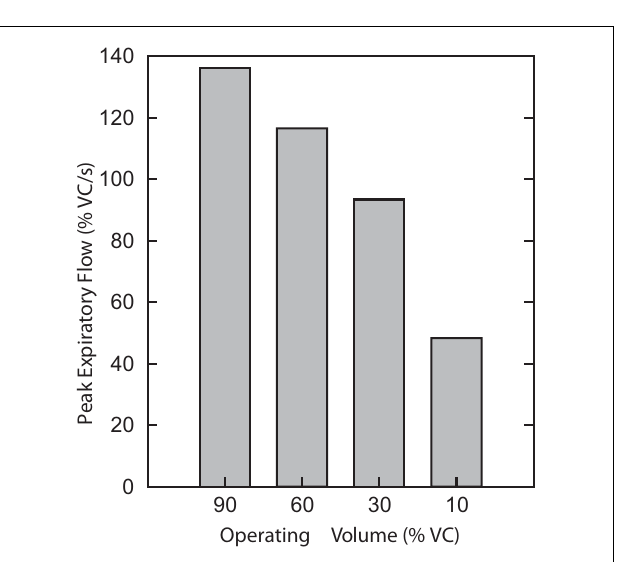
FIGURE 7 | Peak expiratory flow in four coughs simulated with the isolated biomechanical model at different operating volumes but equal peak abdominal pressure of 26.5cmH 2 O. There are no error bars because these are runs of the deterministic